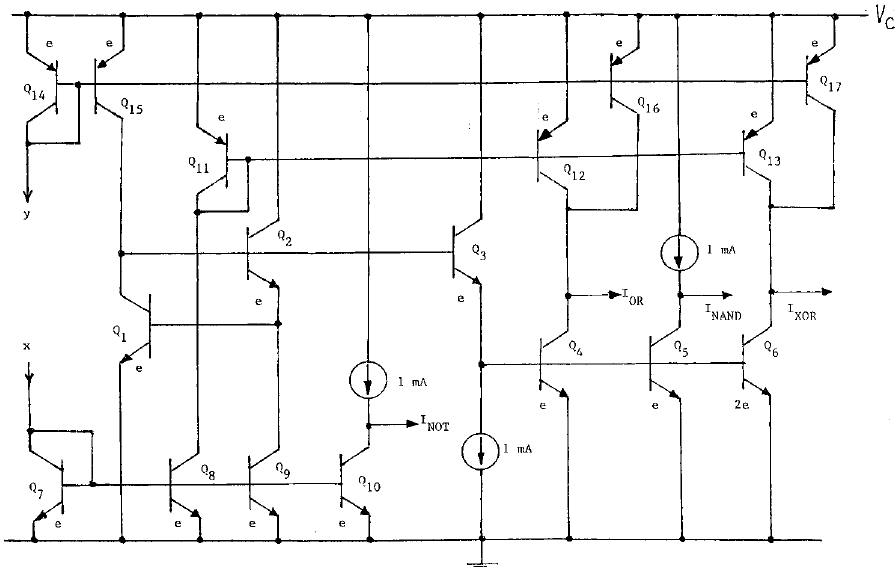
FIGURE 1 Proposed implementation of the NOT = OR = NAND = XOR digital logic functions using analog